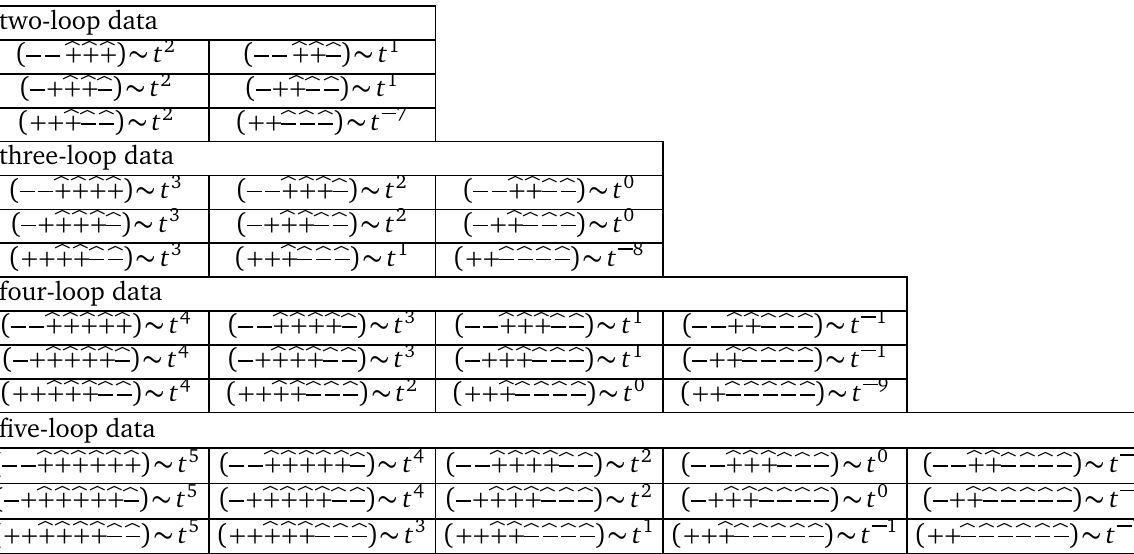
Table 2: Scaling behavior of graviton tree-level amplitudes under the chiral defor- mation defined in Eq. (23) of ( n − 2 ) external legs. The scaling is sorted according to the different helicity configurations of the amplitudes and shifted legs are denoted by (cid:98) ± . The L -loop data corresponds to ( L + 3 ) -point tree-level